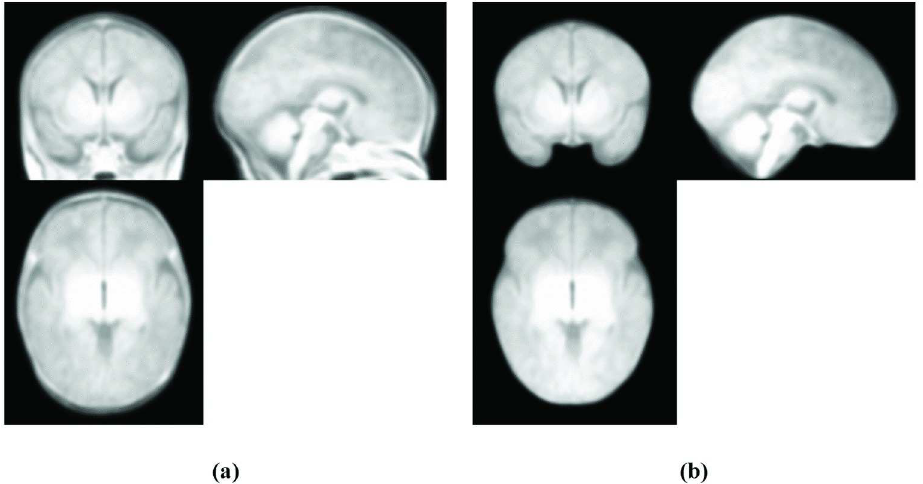
Fig 3. GRAMFC_T 39-42 template and the proposed intracranial template. (a) GRAMFC_T 39-42 template [8], (b) Proposed MR